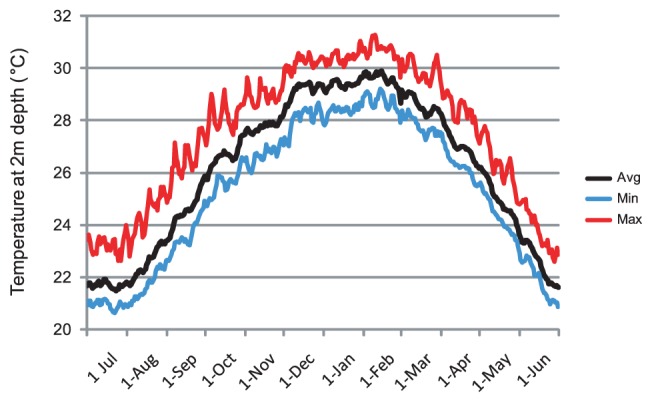
Long term sea temperature at 2 m depth in Geoffrey Bay, Magnetic Island.Data was collected over 15 years (1996–2011) by loggers maintained by the Australian Institute of Marine Science (Channel ID 1820, data available from http://data.aims.gov.au/gbroosdata/services/rss/channel/923/150).